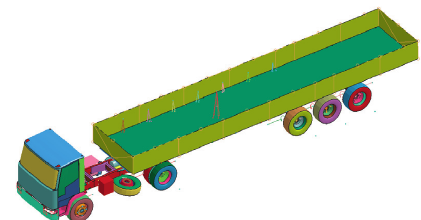
Figure 8: Truck model (National Crash Analysis